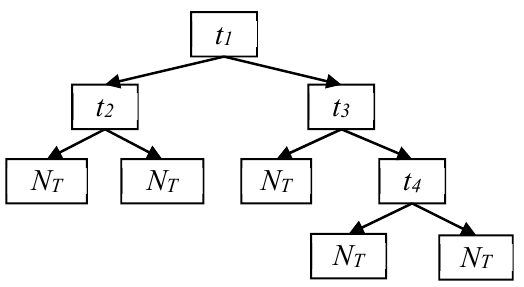
Figure 2. Structure chart of classification and regression trees.